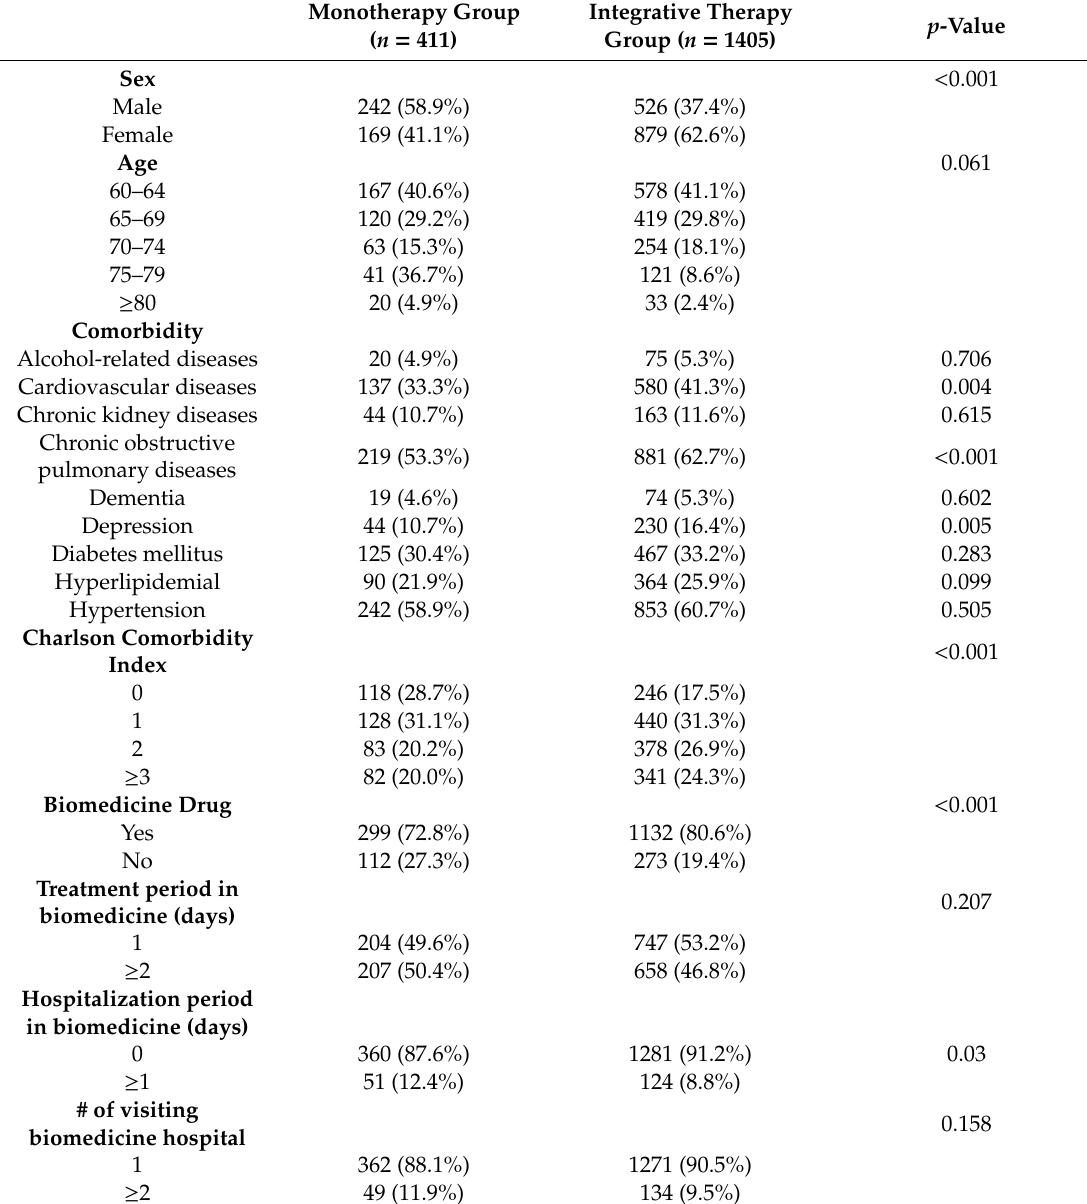
Table 1. Baseline study population